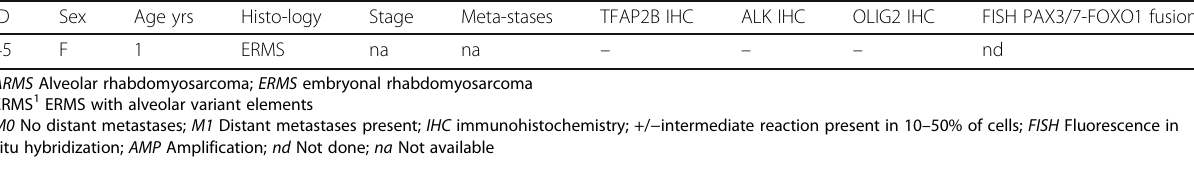
Table 2 List of patients with clinical, immunohistochemical and FISH data (Continued) ID